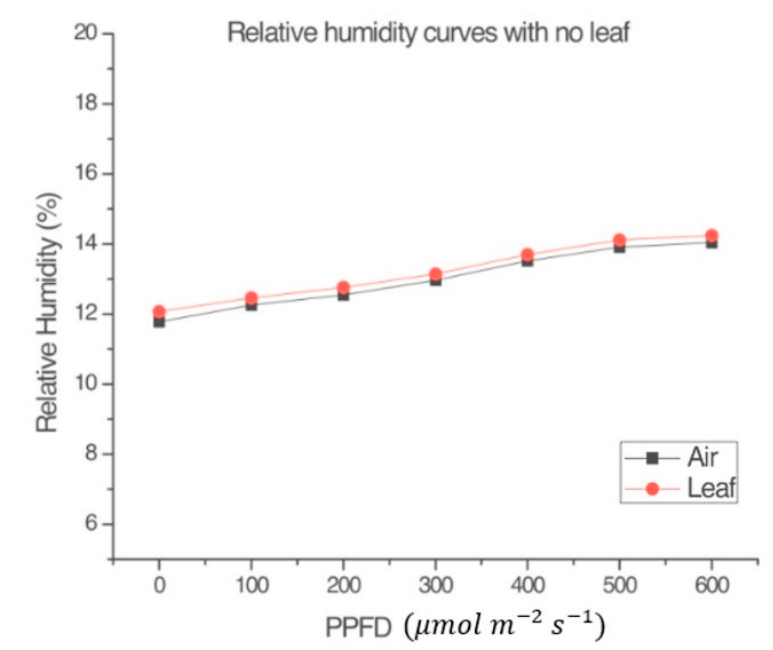
Figure 4. Comparison between the relative humidity of the leaf ( RH l ) inside the measurement cham- ber of the LI-COR Li-6800 and the relative humidity of the air ( RH a ) in the environmental test cham- ber in the absence of the leaf. T a = 23 °C .